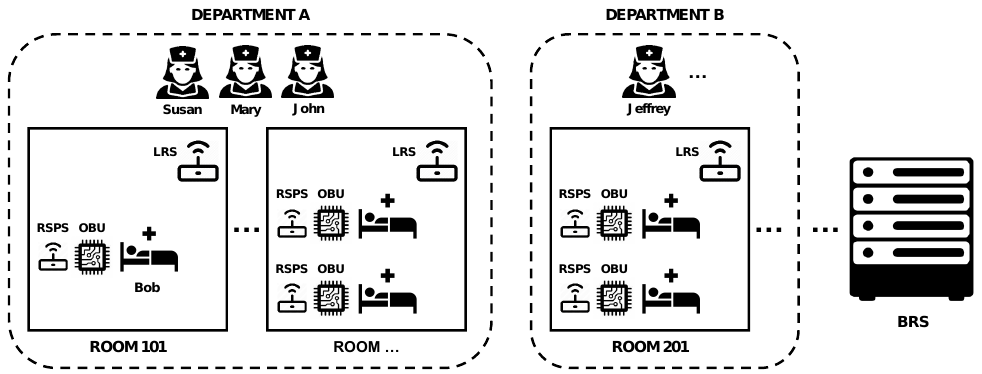
Figure 3. Architectural set-up for the Proof-of-Concept use case. Each hospital room contains one Local Reasoning Service (LRS), and one Observation Unit (OBU) and RSP Service (RSPS) per patient. There is only one Back-end Reasoning Service (BRS) in the hospital. Patient Bob is accommodated in room 101 of department A, which is supervised by nurses Susan, Mary and